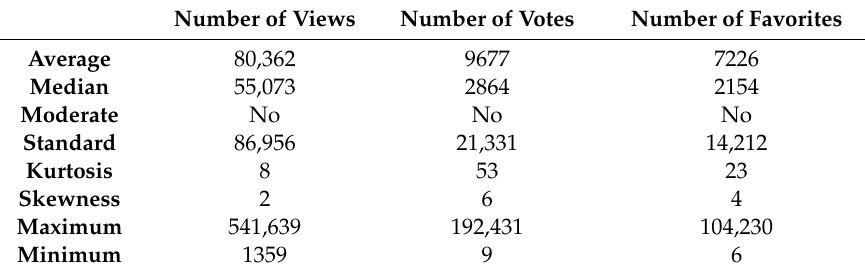
Table 3. Interaction frequency in the e-health community.